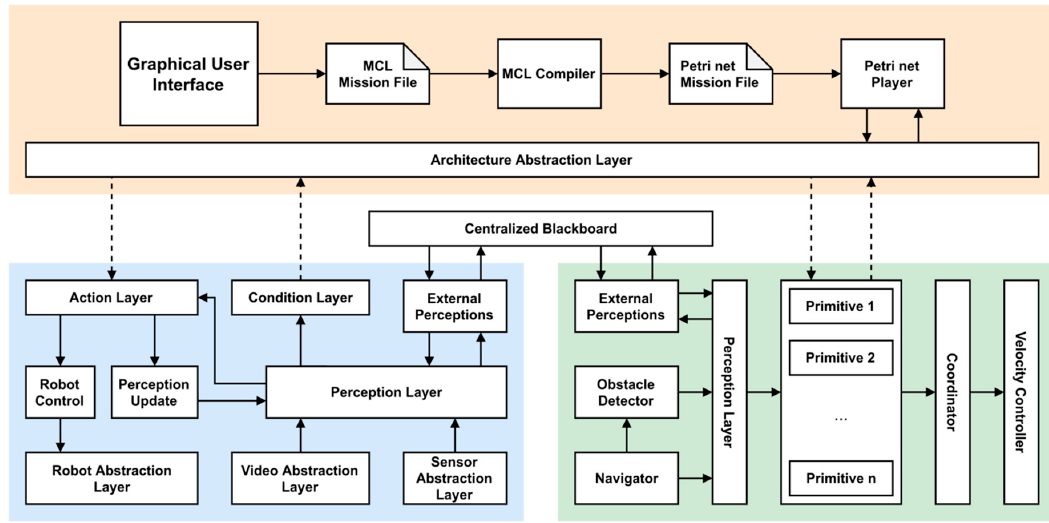
Figure 12. RAUVI proposed architecture.